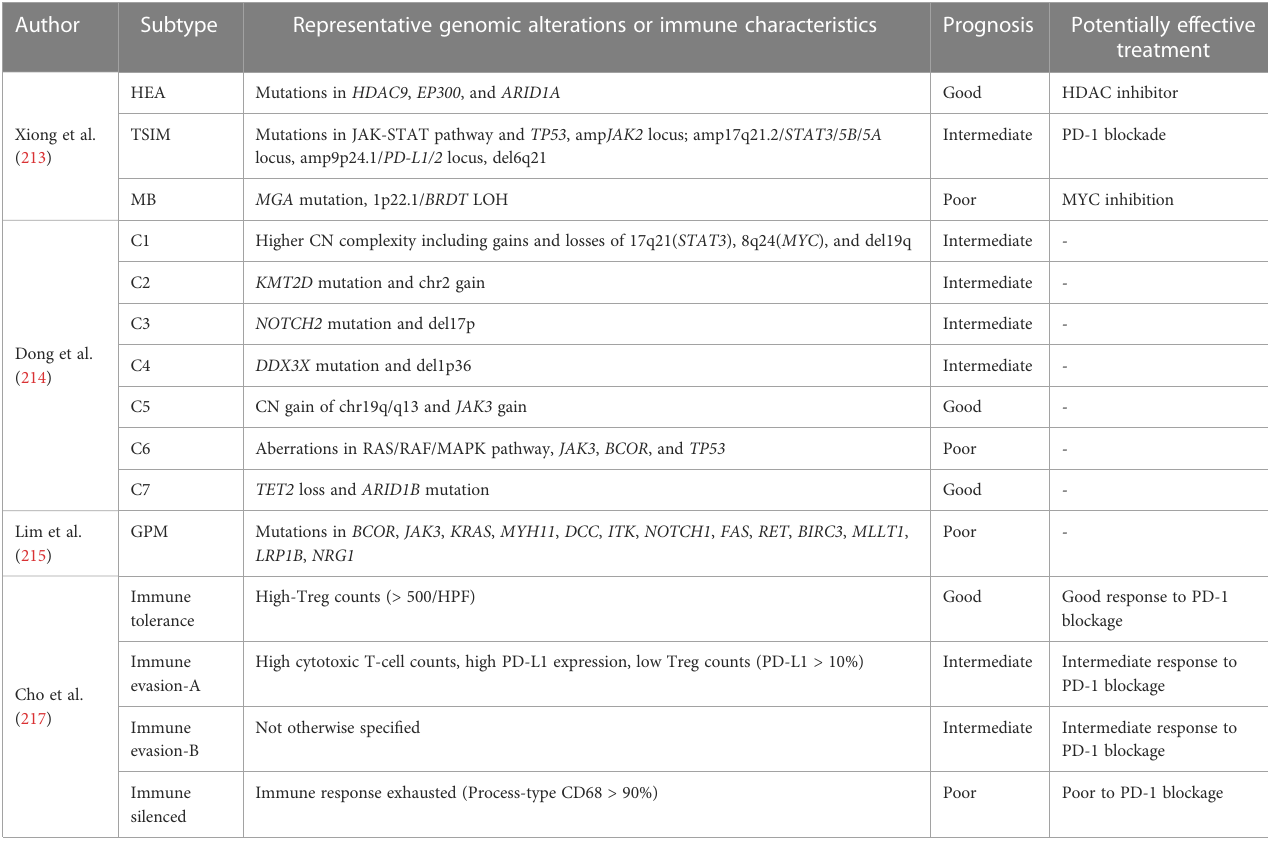
TABLE 4 Molecular subtyping schemes of ENKTCL published in recent